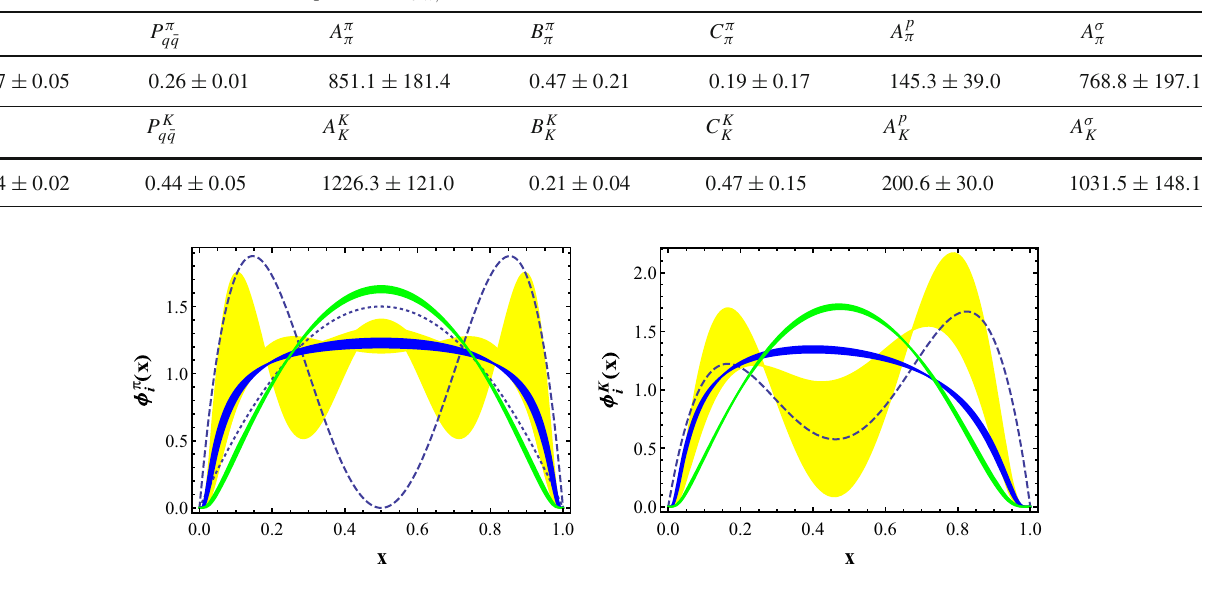
Fig. 2 Thecharacteristicshapesofthedistributionamplitudesforpion andkaoninBHLframewiththescalevalue W ∈ ( 1 , 6 ) GeV. Leftpanel : Yellow band φ π π ; Blue band φ p π ; Green band φ σ π . Dashed line the CZ distribution amplitude, φ CZ π ( x ) = 30 x d x u ( x d − x u ) 2 , dotted line the